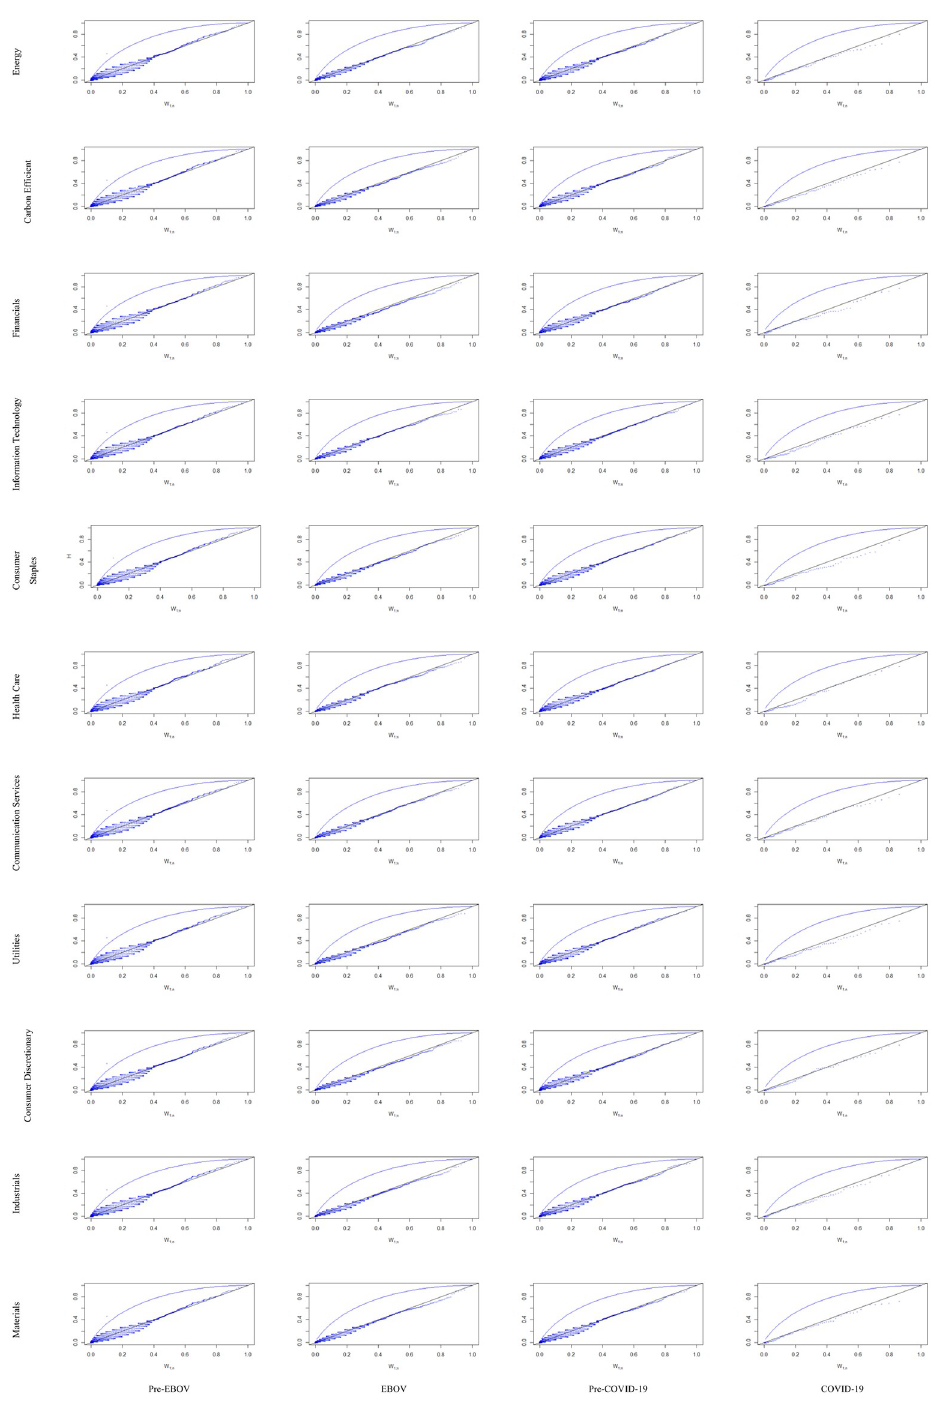
Fig 1. Kendall plot (K-plot) results for bivariate copula. This shows the dependency of sectoral indices on IEMV (https://ndownloader.figshare.com/files/29099883).